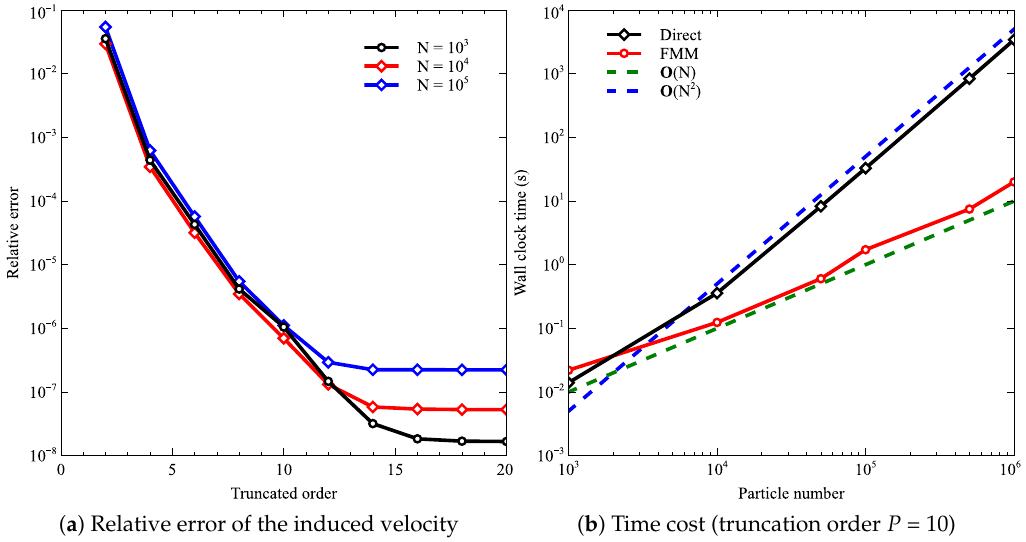
Figure 4. Fast multipole method (FMM) for vortex